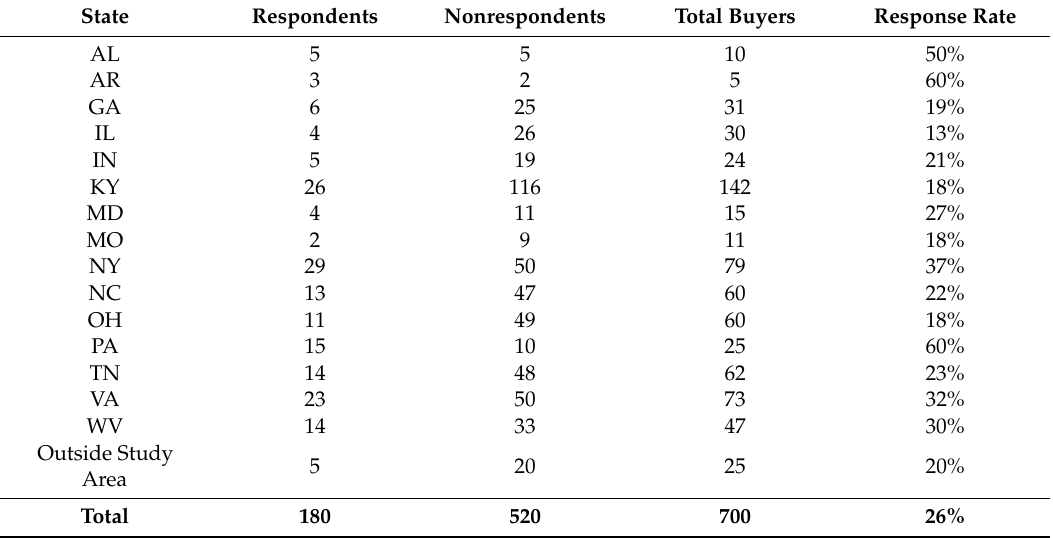
Table 2. Responses across 700 surveyed, registered ginseng buyers in 15 eastern states in the US that were surveyed about purchasing of species other than ginseng (i.e., ‘o ff -roots’) in 2015 and 2016. State Respondents Total Buyers